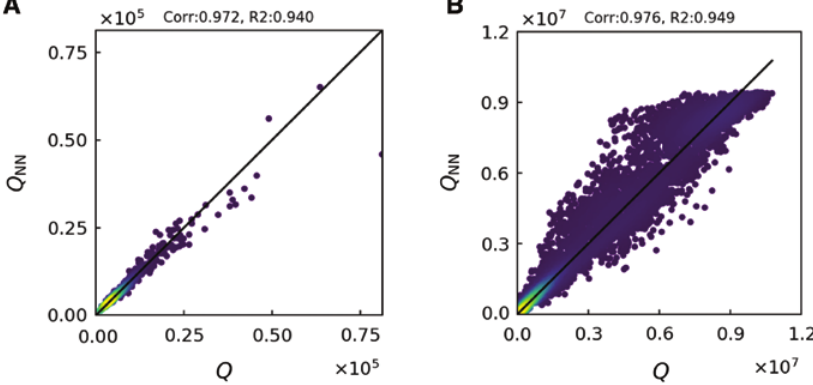
) at different stages. NN